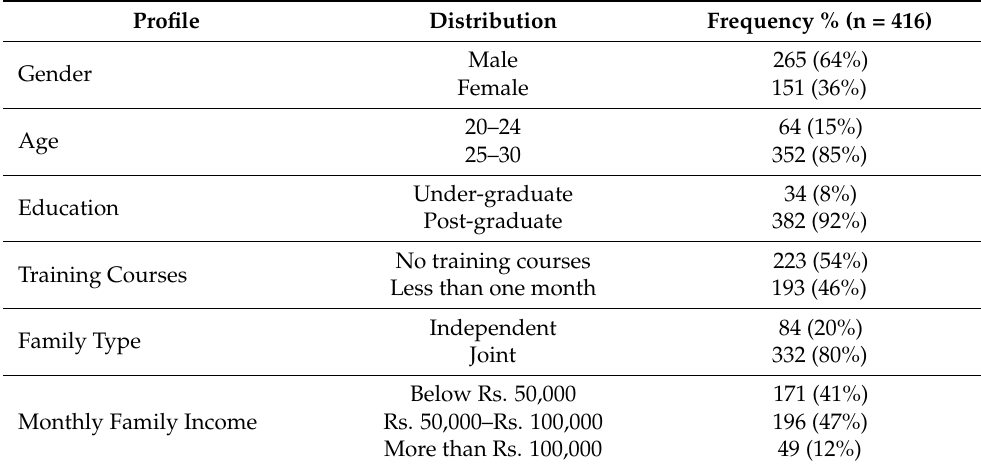
Table 1. Demographical